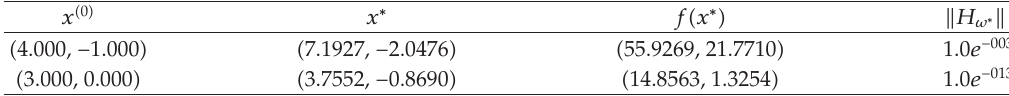
Table 1: Results of Example 4.3.